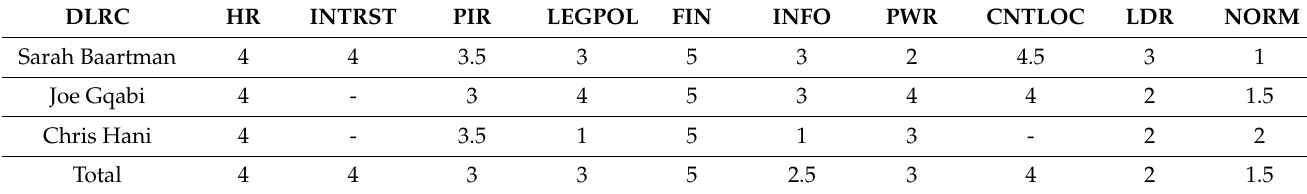
Table 8. Priority areas of external support for collaboration as an innovation (median